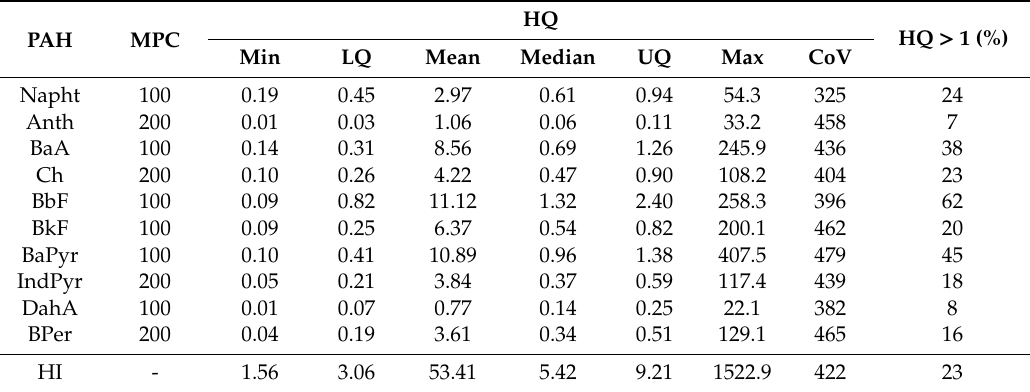
Table2. Descriptivestatisticsofhazardquotient(HQ)forindividualPAHcompoundsandtheacceptable soil screening level (MPC, µ g kg − 1 ) used for HQs calculation; additionally, percentage of soil samples with HQ > 1 is